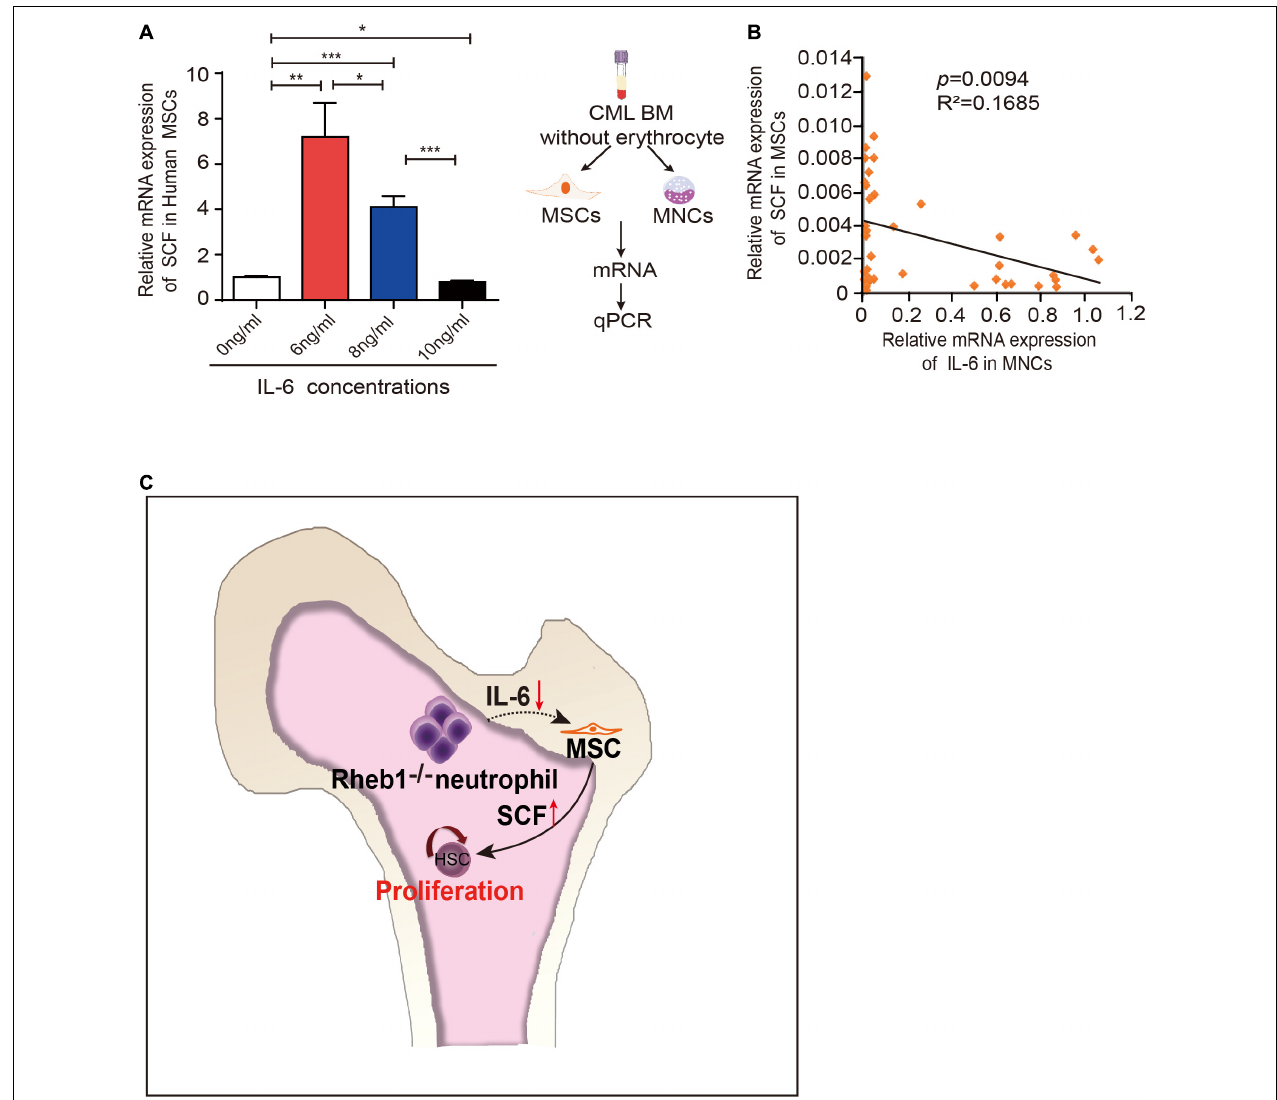
FIGURE 6 | IL-6 regulates SCF expression in human MSCs. (A) The relative mRNA expression of SCF in H-MSCs after exposure to different concentrations IL-6 for 24 h ( n = 3). The data are presented as the mean ± SD. (B) Correlation analysis for SCF and IL-6 mRNA expression in CML patients ( n = 39) ( p = 0.0094). R: Pearson correlation coefficients; R 2 : indicates “the goodness of fit.” Statistical significance was calculated by Pearson correlation coefficients. (C) Model depicting hematopoietic regulation in the absence of Rheb1 . * P < 0 . 05; ** P < 0 . 01; *** P < 0 .